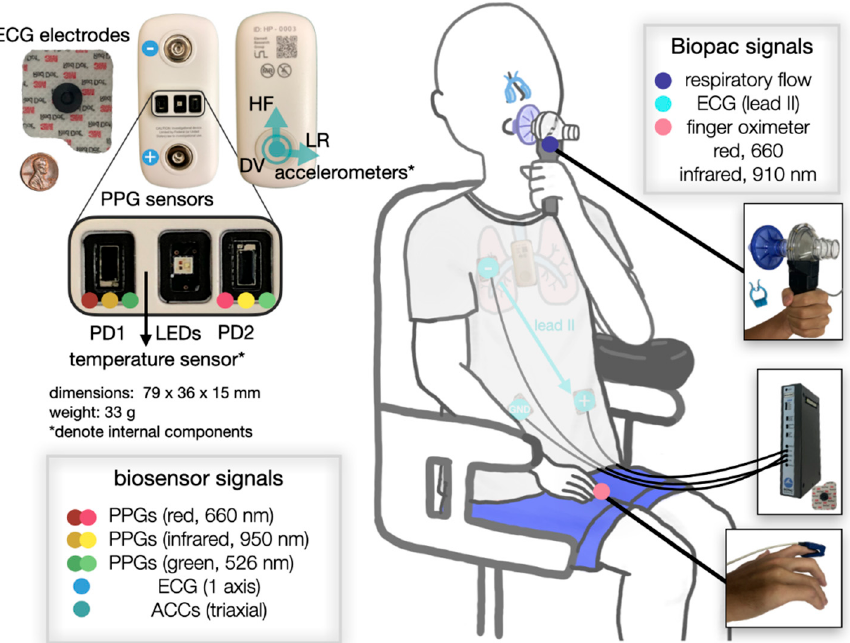
Figure 1. Illustration of a subject undergoing the breath-hold study. Placements of the wearable patch biosensor ( left side) and the ground truth Biopac sensors ( right side) are depicted. The relative size of the biosensor is shown with an off-the-shelf ECG electrode and a penny. Note that the photodiode (PD) has an area of 4.5 mm 2 . PD1 is on the left side and PD2 is on the right side of the subject. In parallel, we also attached the wearable patch biosensor to the subject’s mid-sternum and collected single-lead ECG, two sets of multiwavelength PPGs (red, infrared [IR], and green), and triaxial seismocardiogram (SCG, not used in this study), sampled at 500, 67, and 1000 Hz, respectively. The hardware used in the biosensor is almost identical to that reported in our previous work [8,10,23] except for the addition of the PPG modules and the change in form factor. The ECG analog front-end (AFE) and the accelerometer AFE (for SCG) remain the same. Specifically, the PPG AFE used to drive the LEDs and obtain data from the PDs is the Maxim 86170 (Maxim Integrated, San Jose, CA, USA). The multi-chip LEDs, which has red (660 nm), and IR (950 nm), and green (526 nm) wavelengths, are the SFH 7016 (OSRAM, Munich, Germany), and the PDs are the VEMD 8080